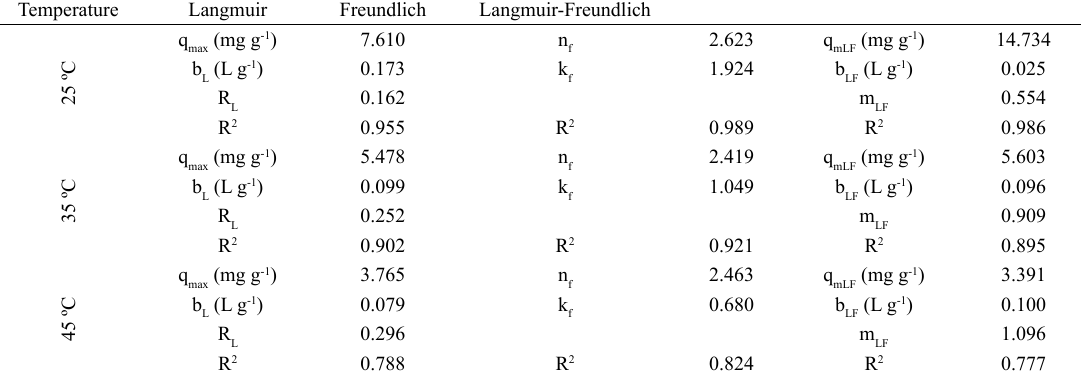
Table 4. Adsorption isotherm parameters of the Langmuir, Freundlich and Langmuir-Freundlich models for temperatures of 25 °C, 35 °C and 45 °C.